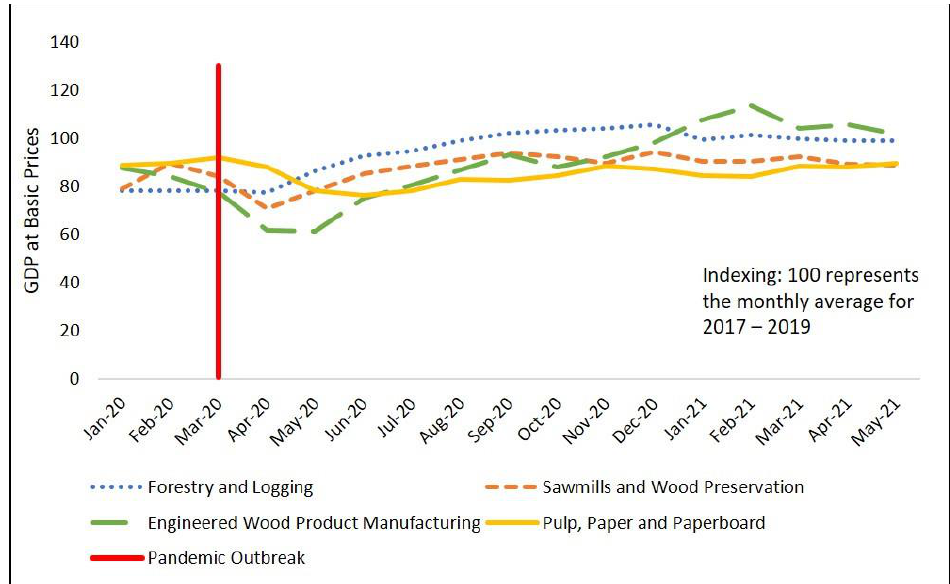
Figure 4. Monthly gross domestic product (GDP) for forest industry subsectors.